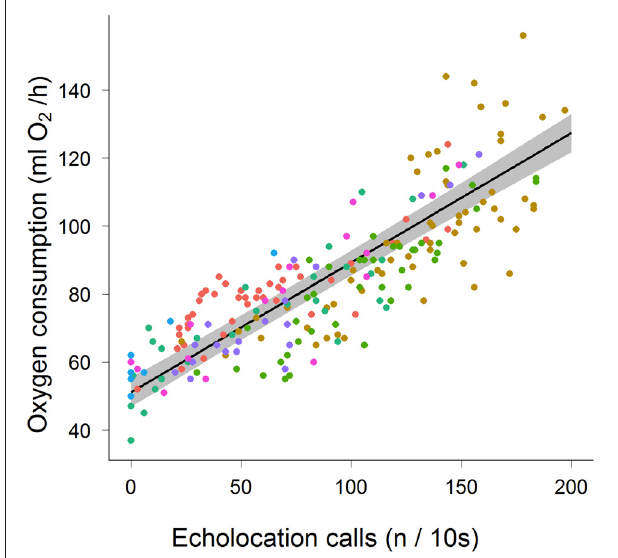
FIGURE 1 | Metabolic rate (ml O 2 /h) for seven Noctilio albiventris (indicated by different colors) in relation to echolocation pulse rate (n/10s). The mean metabolic rate as estimated by the model is the black line with the 95% credible interval indicated by the gray area.